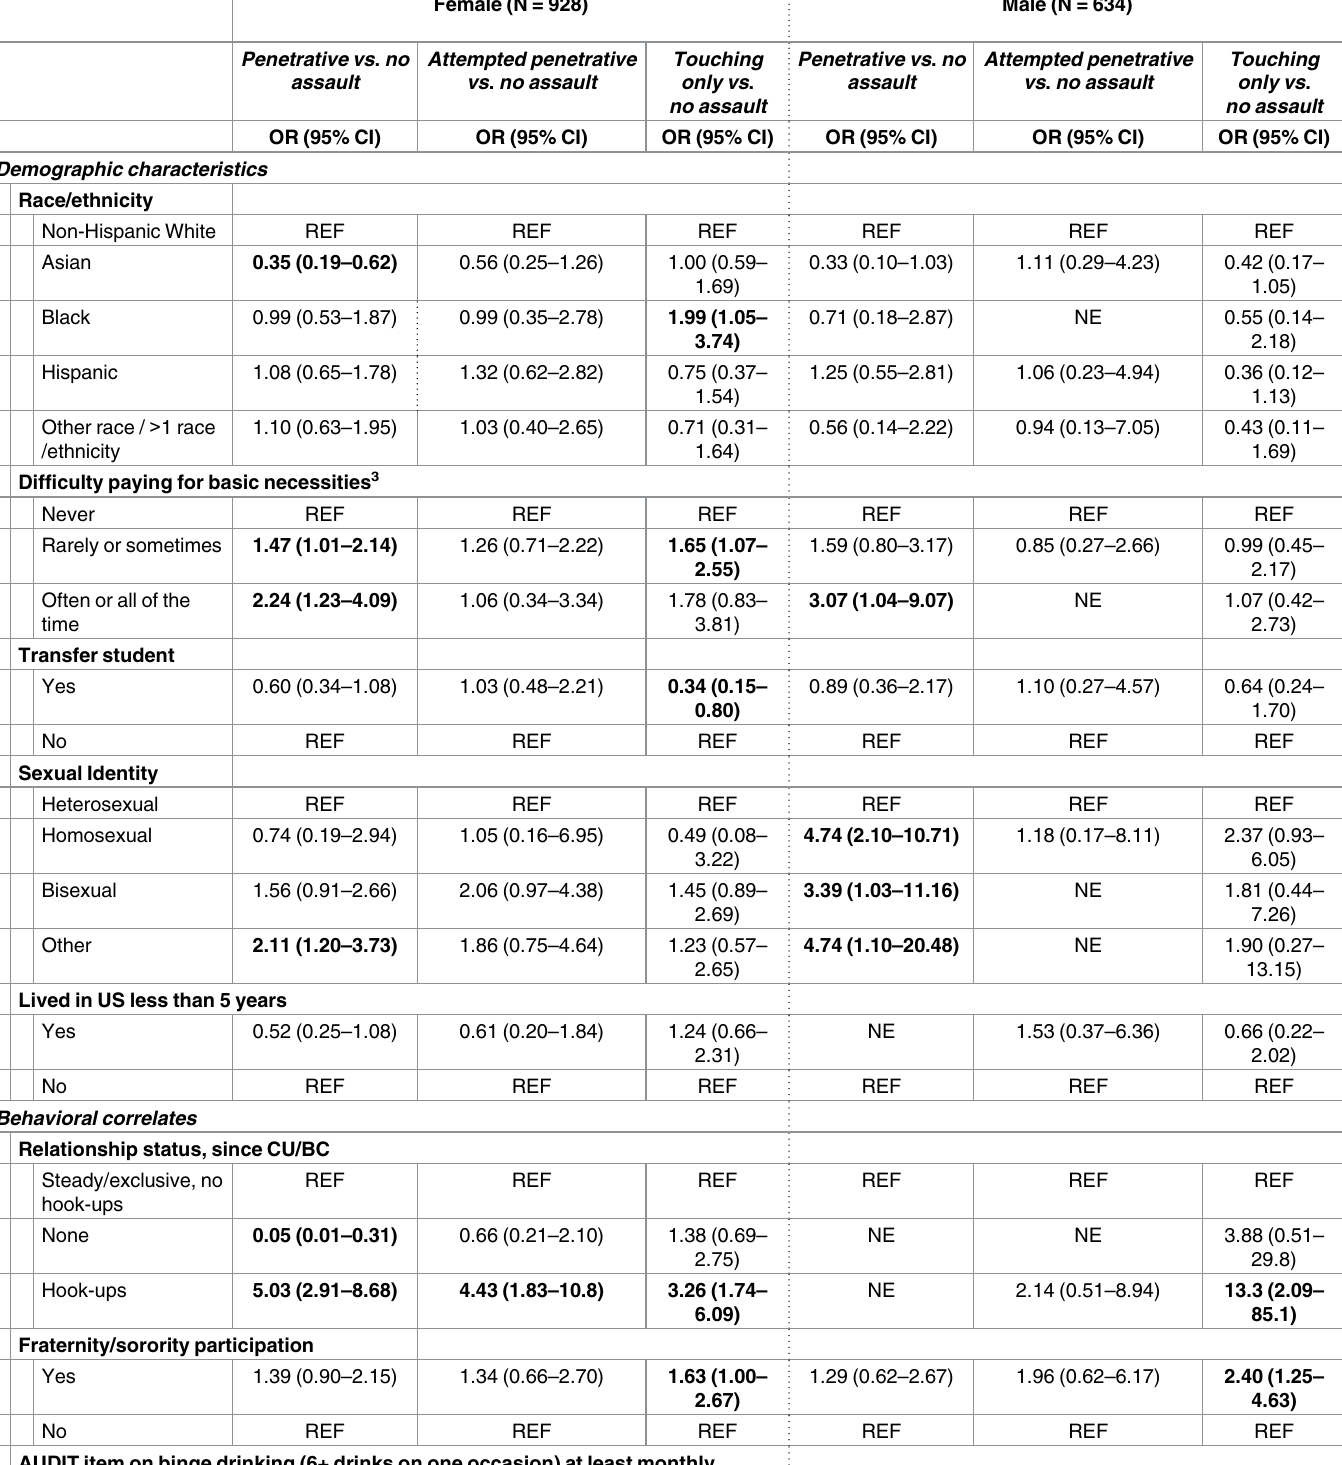
Table 5. Associations between demographic and behavioral characteristics and each type of sexual assault since enrolling at CU/BC, by